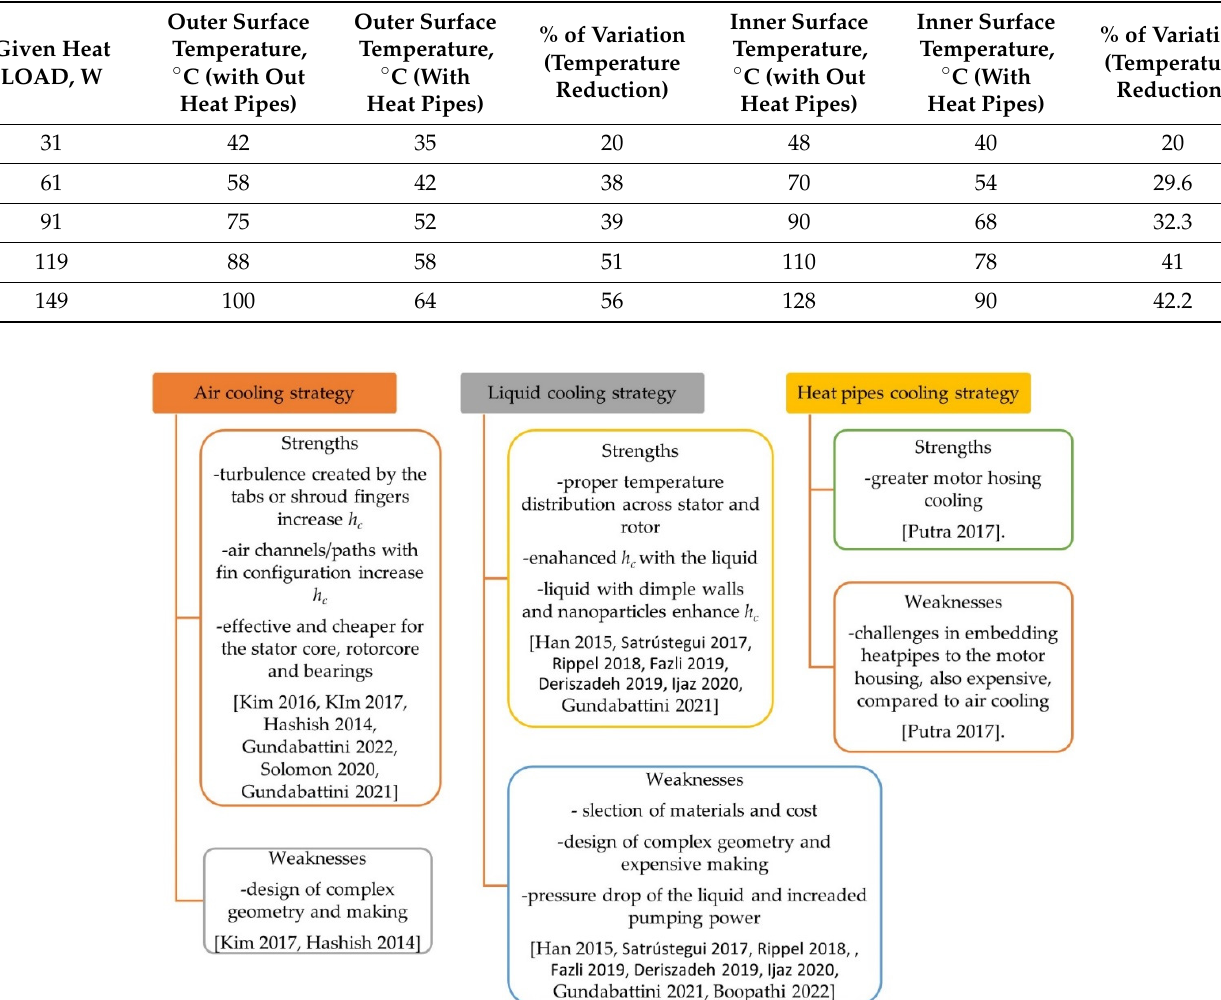
Figure 13. Schematic of L-shaped flat heat pipes mounted on an electric motor model [53]. Table 9. Effect of heat pipe implementation [52]. Table 9. Effect of heat pipe implementation [52].